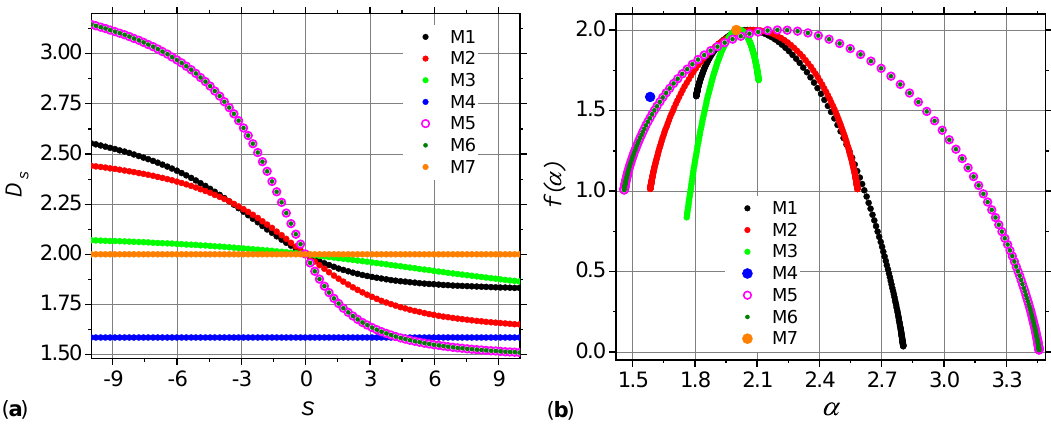
Figure 3. Generalized dimensions D s ( a ) and f ( α ) spectra ( b ) for the configurations M1, M2, M3, M4, M5, M6 and M7. See Table 1 for the corresponding probabilities p 1 , p 2 , p 3 and p 4 .